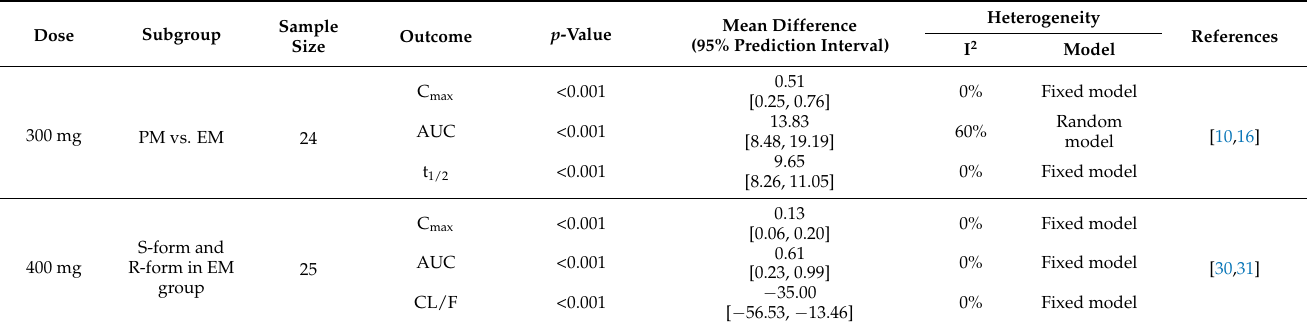
Table 2. Results of meta-analysis regarding propafenone pharmacokinetics.